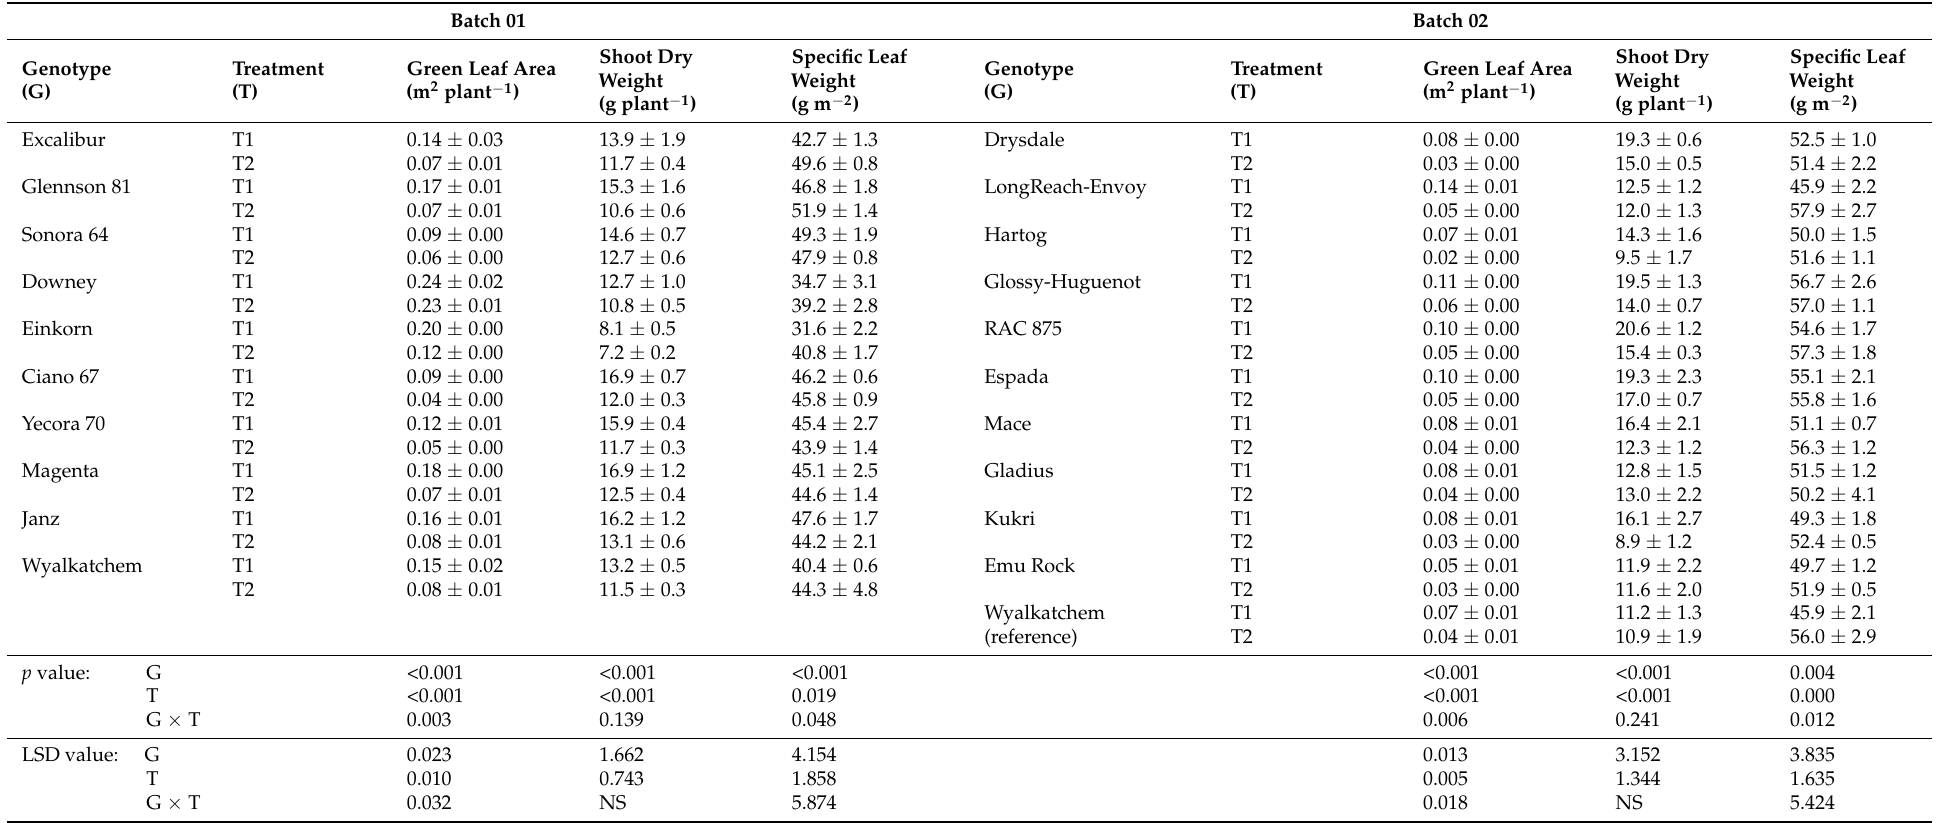
Table 2. Green leaf area, shoot dry weight, and specific leaf weight of 20 wheat genotypes in Batch 01 and Batch 02 under ambient (T1) and high (T2) temperature regimes. Values presented are means ± SEM, n =